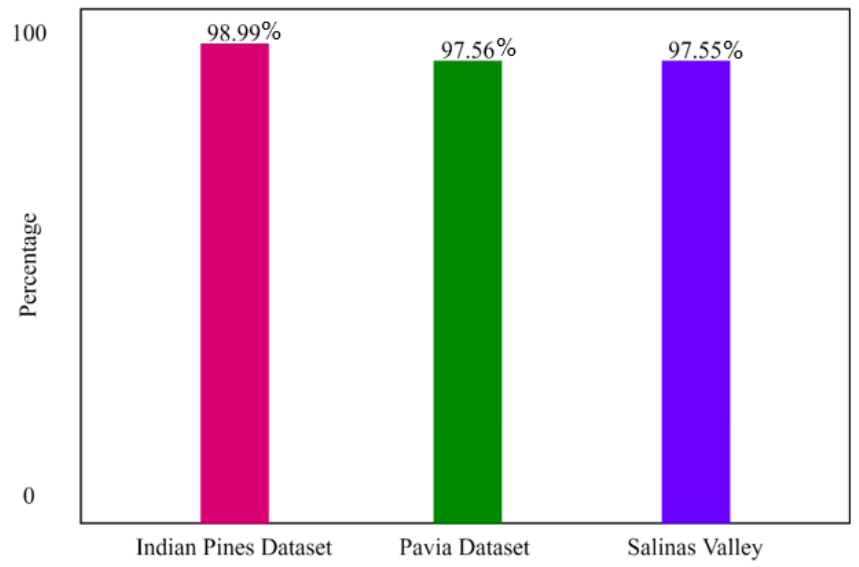
Figure 12. Detection of Areas in Salinas Dataset: ( a ) Segmented Image; ( b ) Detection.